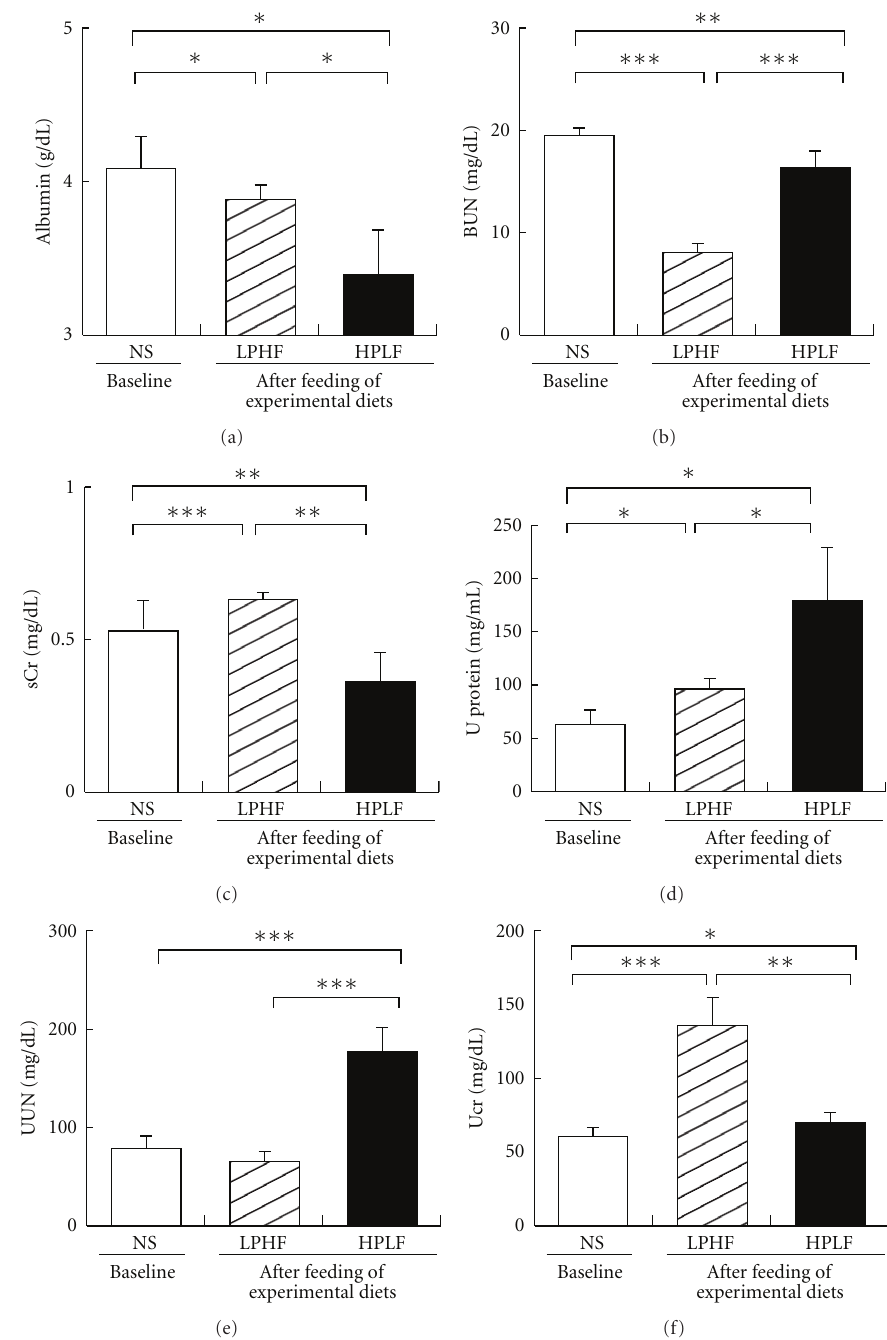
Figure 2: Blood and urinary clinical parameters. NS: weekly intraperitoneal injection of adriamycin (2mg/kgBW) for six weeks. LPHF: weekly intraperitoneal injection of adriamycin (2mg/kgBW) for 6 weeks thereafter a 7% protein and 40% fat diet for five weeks. HPLF: weekly intraperitoneal injection of adriamycin (2mg/kgBW) for 6 weeks thereafter a 30% protein and 7% fat diet for five weeks. BUN : blood urea nitrogen, Scr: serum creatinine. UUN: urinary urea nitrogen, Ucr: urinary creatinine, Ccr: creatinine clearance. ∗ Statistical di ff